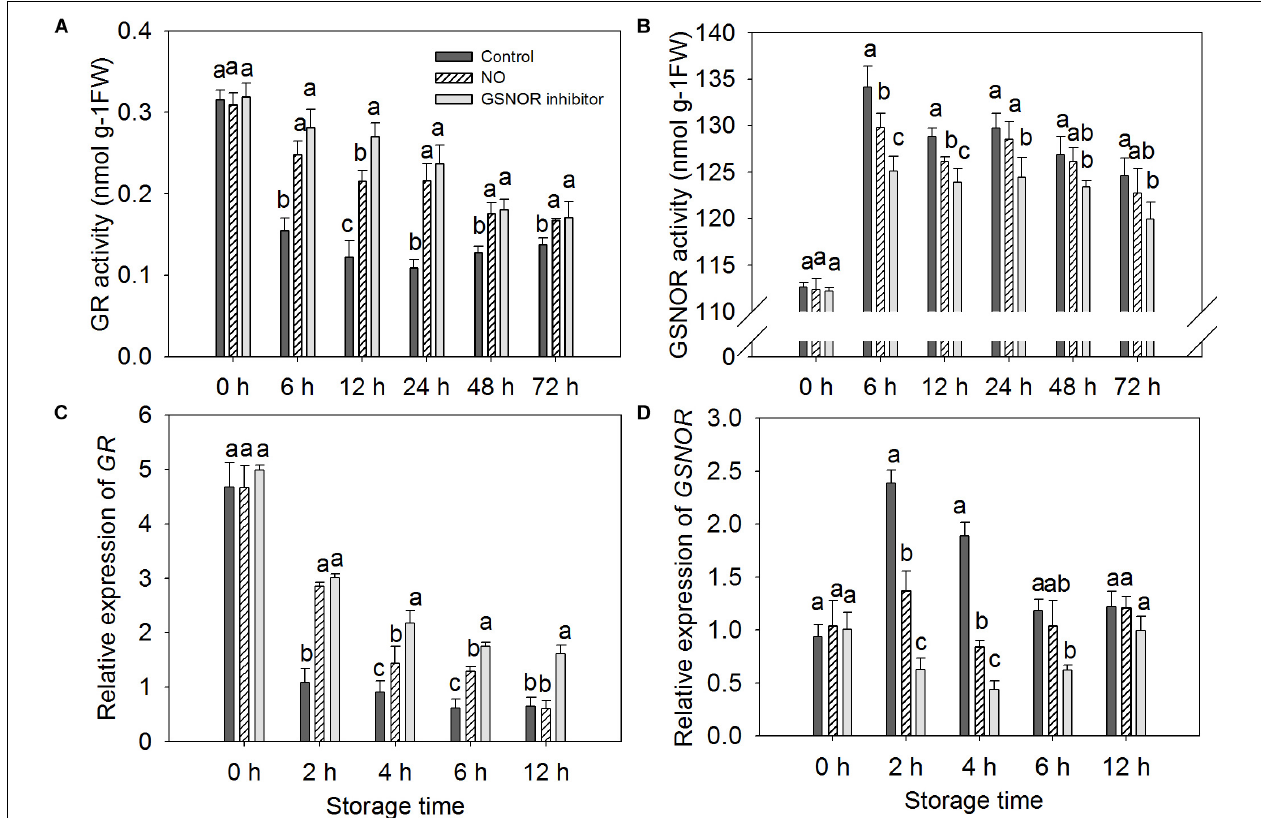
FIGURE 2 | Effect of nitric oxide (NO) or S -nitrosoglutathione reductase (GSNOR) inhibitor treatment on the activity of (A) glutathione reductase (GR) and (B) GSNOR and the (C) gene expression of GR and (D) GSNOR of peach fruit storage at 23 ◦ C. Vertical bars represent the standard deviation of the means ( n = 6). Different letters represent significant differences ( P < 0.05) according to least significant difference (LSD)